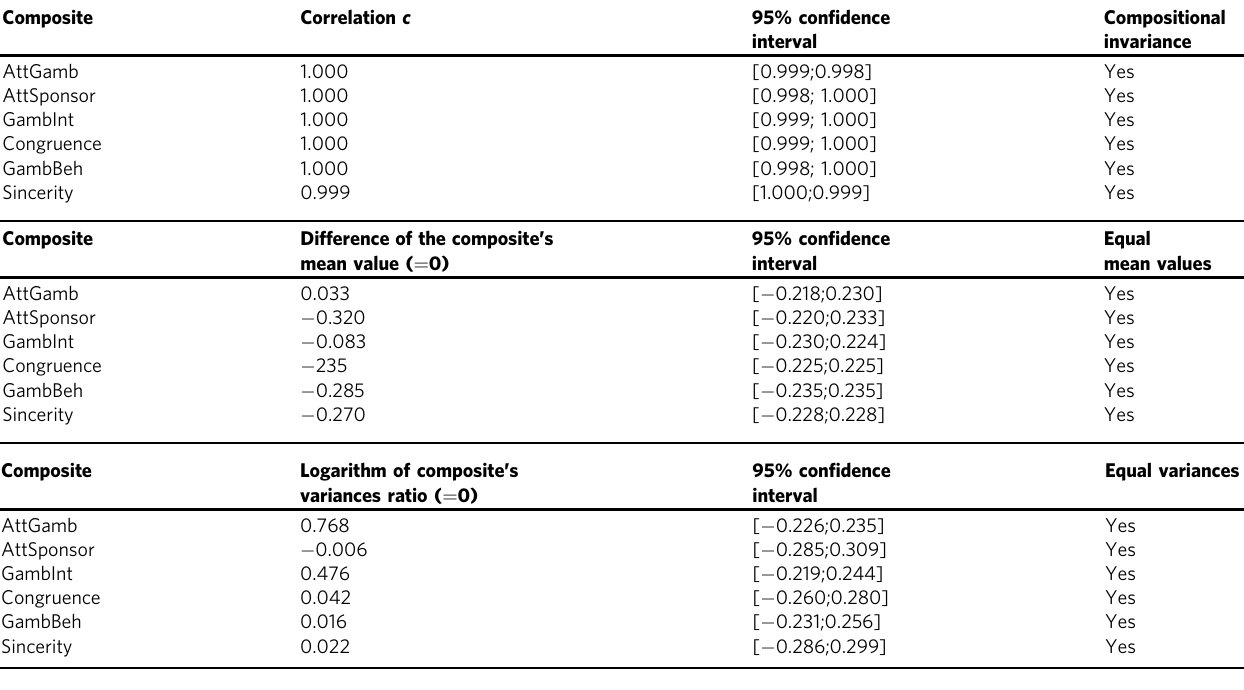
Table 6 MICOM results of the theoretical model (5000 permutations, signi fi cance level 0.05, two-tailed).